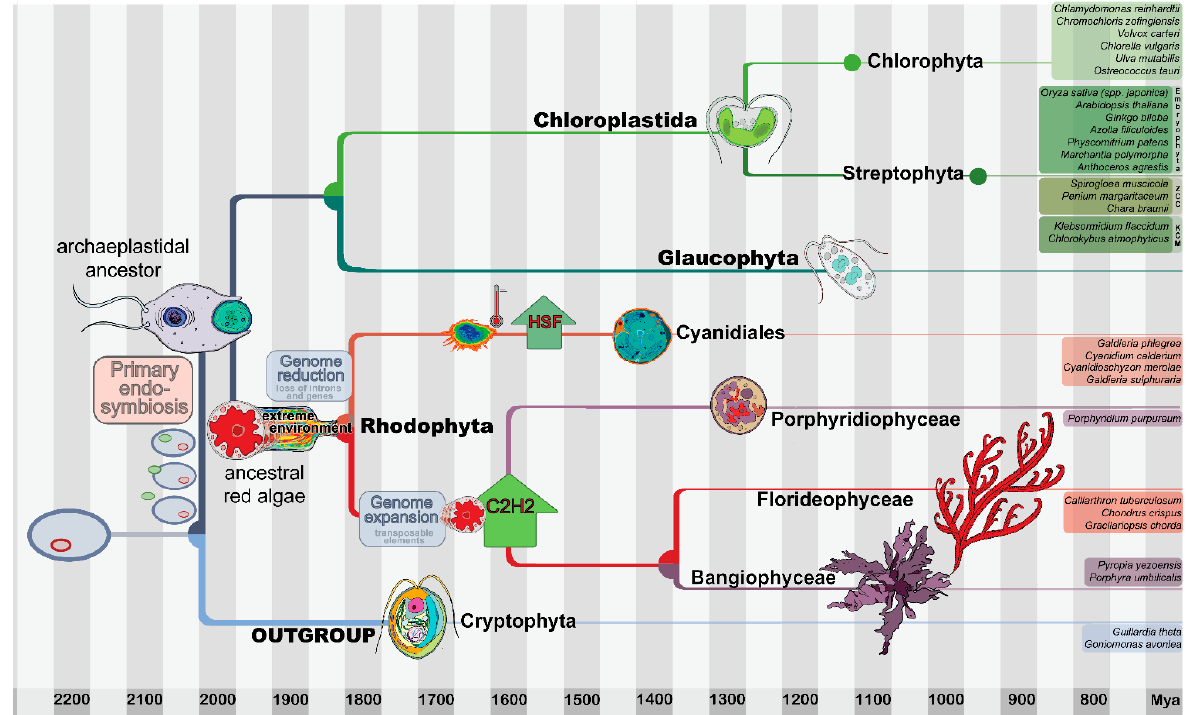
Figure 1. The evolution of the Archaeplastida with a focus on red algae. The Archaeplastida are characterized by the synapomorphic gain of a primary plastid (surrounded by two membranes). Archaeplastida comprises the Chloroplastida (green lineage, including land plants within the Streptophyta), the Glaucophyta, and the Rhodophyta (red algae). For the evolutionary analyses conducted in this study, the archaeplastidal tree of life was outgroup-rooted using the Cryptophyta, which are a sister group [24]. The most recent common ancestor (MRCA) of red algae is hypothesized to have gone through a phase of genome contraction caused by adaptation to extreme environments. The extant, exclusively unicellular Cyanidiales live in extreme environments and are a sister group to the Porphyridiophyceae, Bangiophyceae, and Florideophyceae. Due to the multicellular members of the Bangiophyceae and the entirely multicellular Florideophyceae, secondary gains of complexity (after the genome reduction event) are evident in both latter lineages. The tree as well as the timeline are based on a recently published molecular clock analysis [2] and comprehensive phylogenetic analyses [25,26]. The nodes within the phylogeny are placed according to the data split times (see bottom timeline), and the position of the cartoons of the analyzed species represent the first split within the respective lineage. Primary endosymbiosis, genome reduction and expansion, as well as the HSF expansion and C2H2 abundance discussed in this work are depicted. The species used for the analyses are listed to the right.